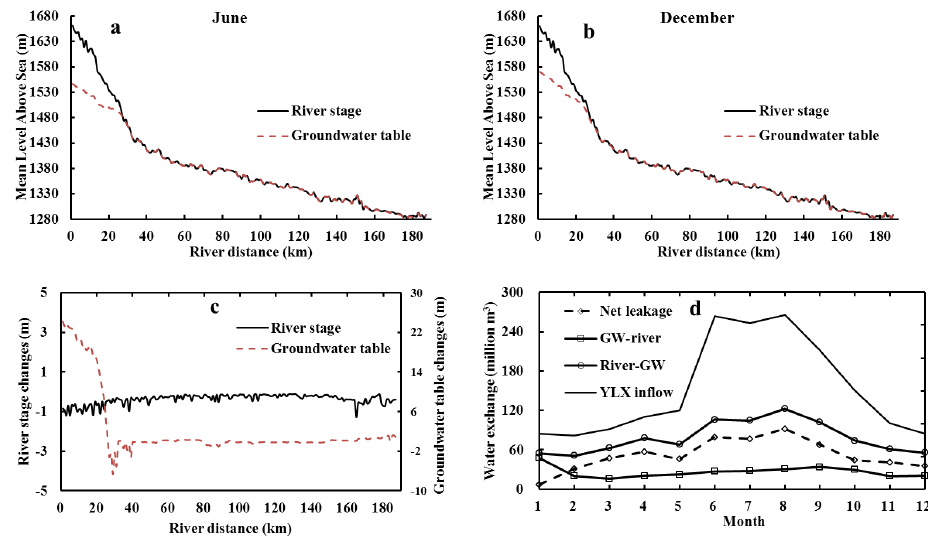
Figure 2. Simulated groundwater table and river stage along river distance in (a) June and (b) December; (c) difference between December and June (December − June); (d) temporal stream–aquifer exchanges within year.